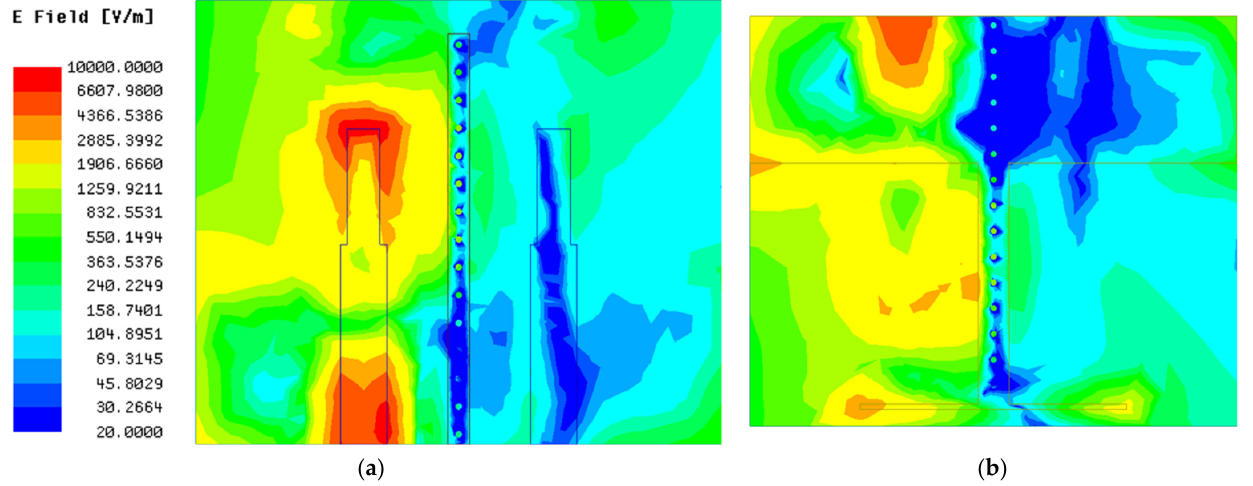
Figure 10. The distribution of surface electric field of antenna 4: ( a ) top surface; ( b ) bottom surface.